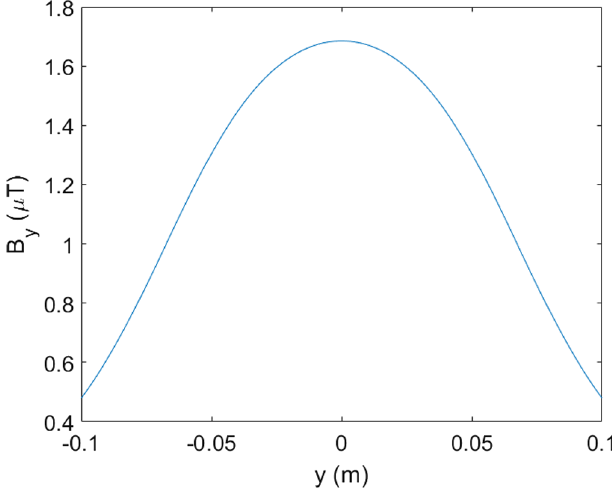
FIG. 29. B component along the transverse coordinate y y